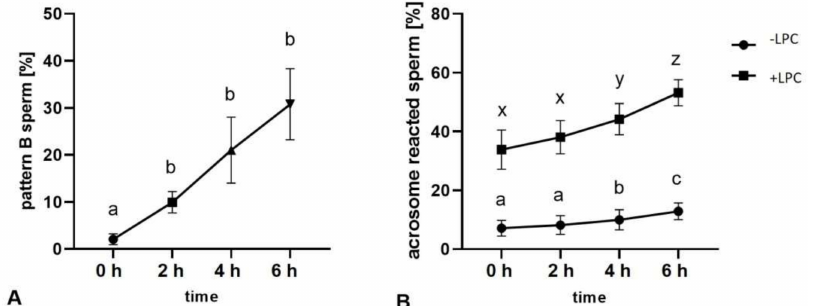
Figure 2. Kinetics of pattern B accumulation in the CTC-stained spermatozoa, corresponding to the progression of bull sperm capacitation ( A ); assessment of spontaneous AR ( • ) and LPC-induced acrosome reaction ( (cid:4) ) ( B ) after 0, 2, 4 and 6 h of incubation in the capacitation-supporting buffer. Dif- ferent letters indicate significant differences ( p < 0.05) among timepoints. All values are represented as the mean ± SEM ( n =